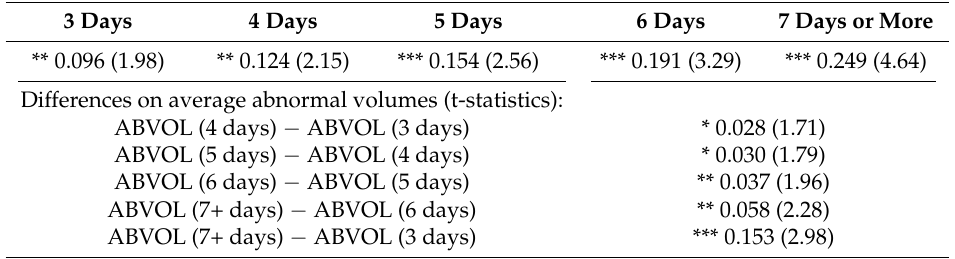
Table 1. Average abnormal trading volumes following sequences of the same-sign stock returns. Panel A: Average Abnormal Trading Volumes (t-Statistics) for the Days Following